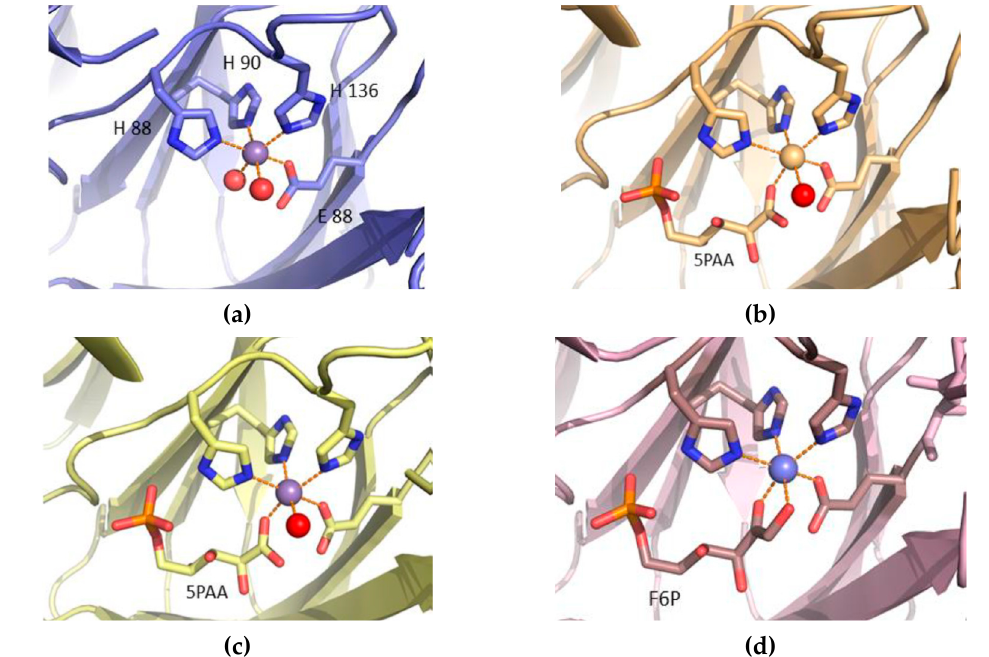
Figure 6. Mn 2 + coordination in the mutant PfPGI structures. For all mutant structures, the Mn 2 +